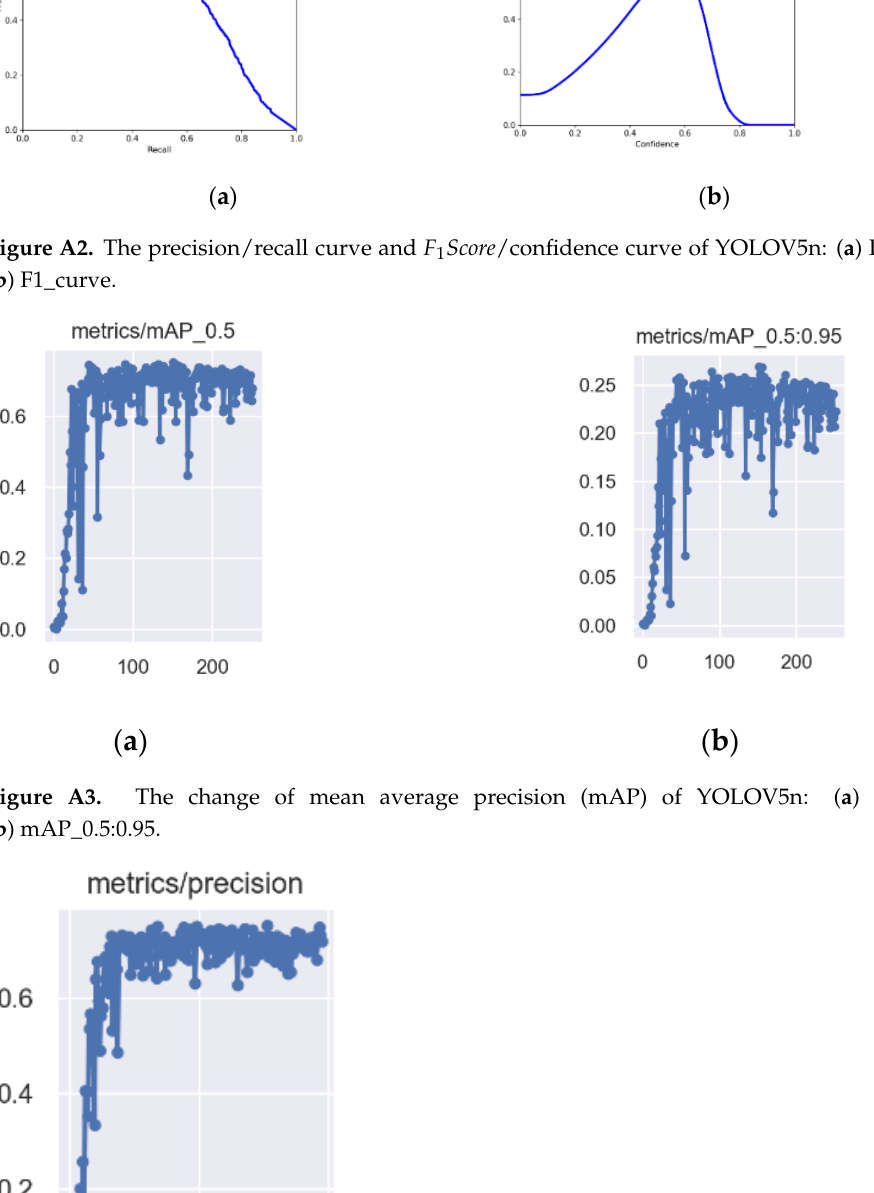
Figure A1. The changes of recall of YOLOV5n.